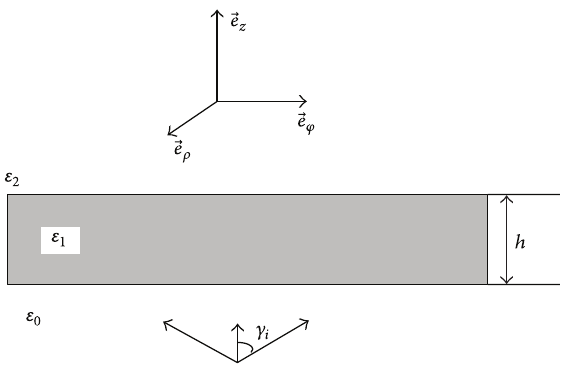
Figure 1: Schematic representation of the structure including a metallic layer ( 𝜀 1 ), a substrate ( 𝜀 0 ), and a targeted ( 𝜀 2 ) medium.